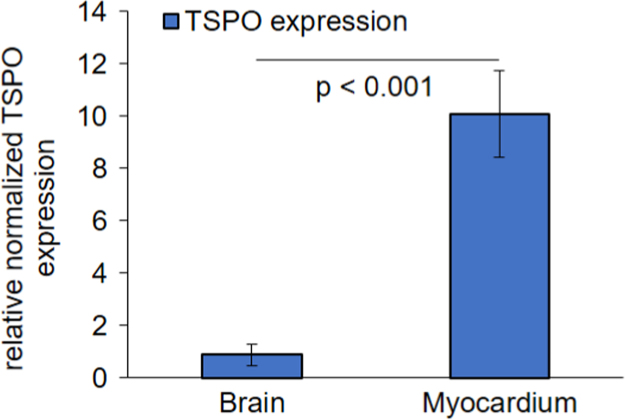
Quantitative polymerase chain reaction assessment of TSPO gene expression in brain and myocardium. Bar graphs show relative normalized (actin-beta and glyceraldehyde 3-phosphate dehydrogenase) TSPO expression as assessed by the quantitative polymerase chain reaction. TSPO expression was 11-fold higher in the myocardium compared to that in brain. Data derive from N = 6 C57Bl/6 mice at seven months of age. Error bars indicate standard deviations. Single data points are available in the supplement.